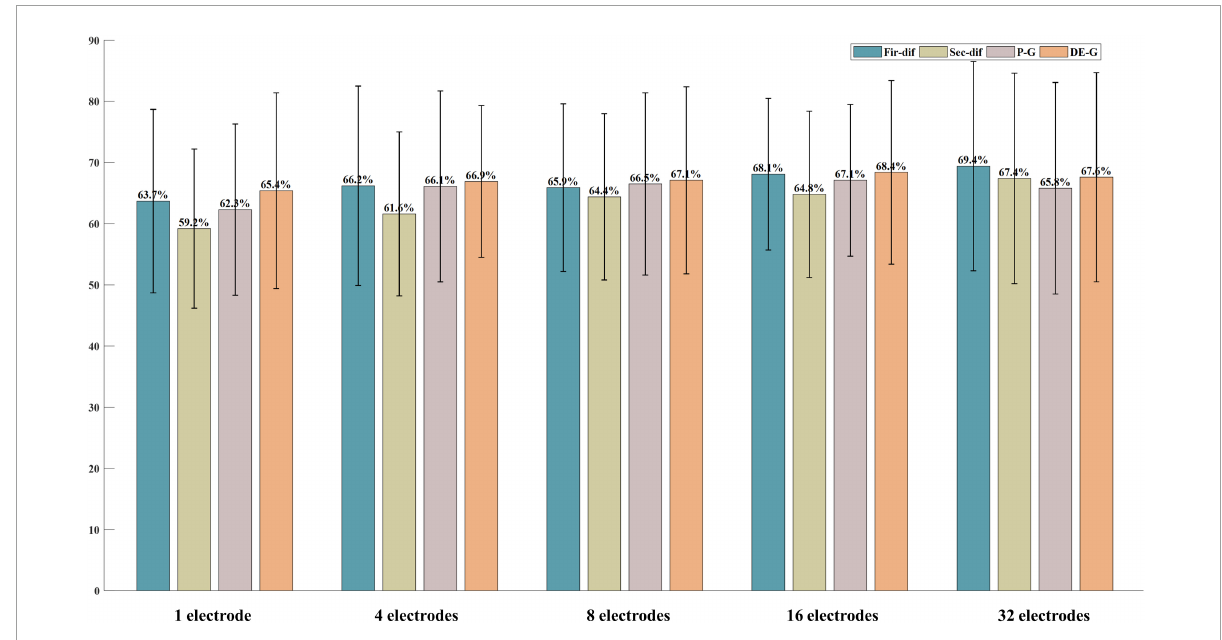
FIGURE9 The classification results of features from 1, 4, 8, 16, and all 32 electrodes on the DEAP